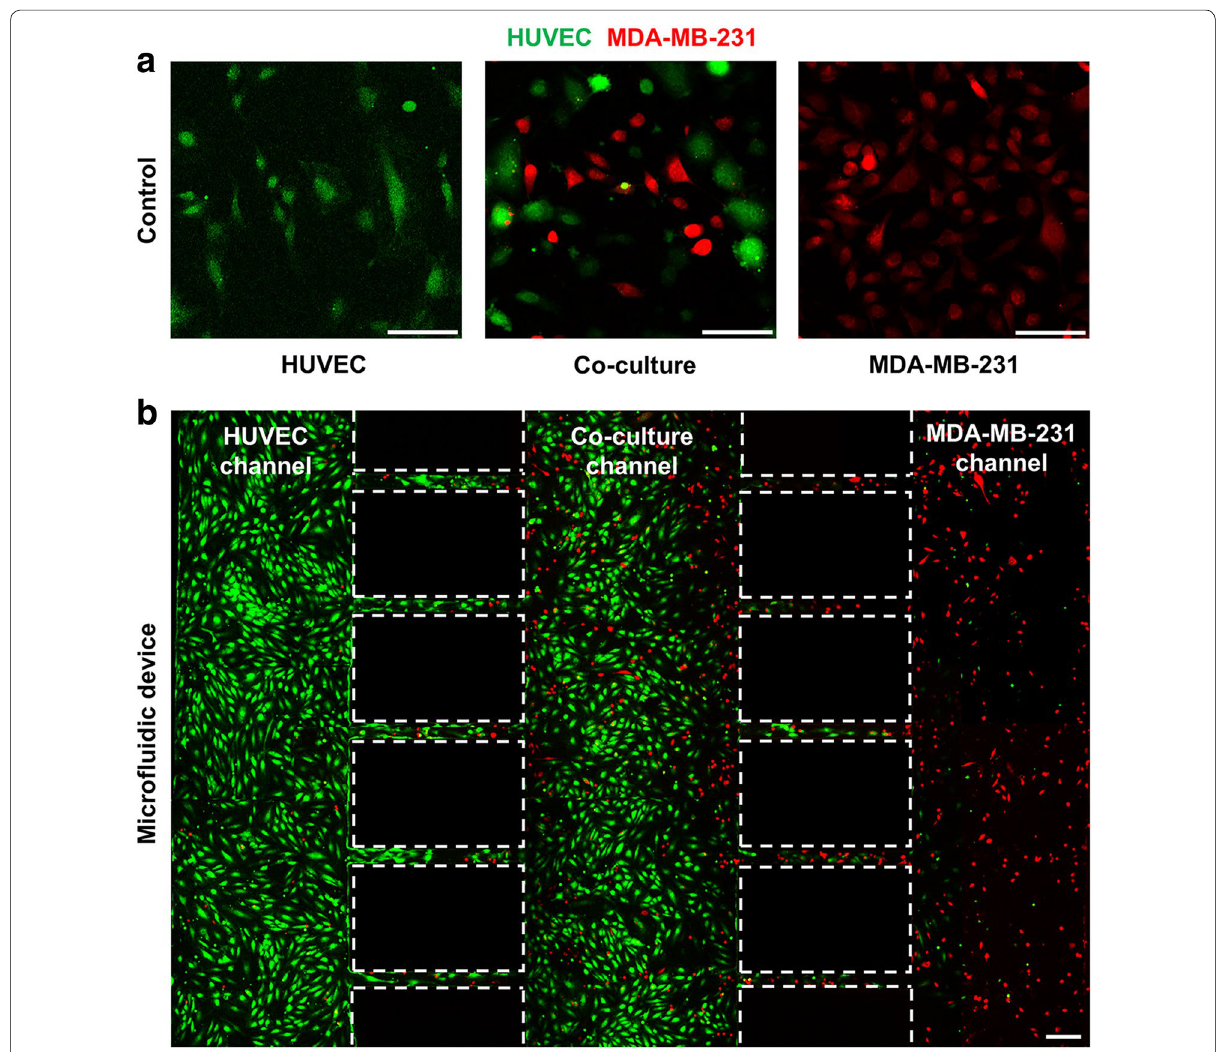
Fig. 5 Confocal laser scanning microscopy images of HUVECs (green) and MDA‑MB‑231breast cancer cells (red) in a culture dish ( a ), in a microfluidic co‑culture platform ( b ). Scale bars are 100